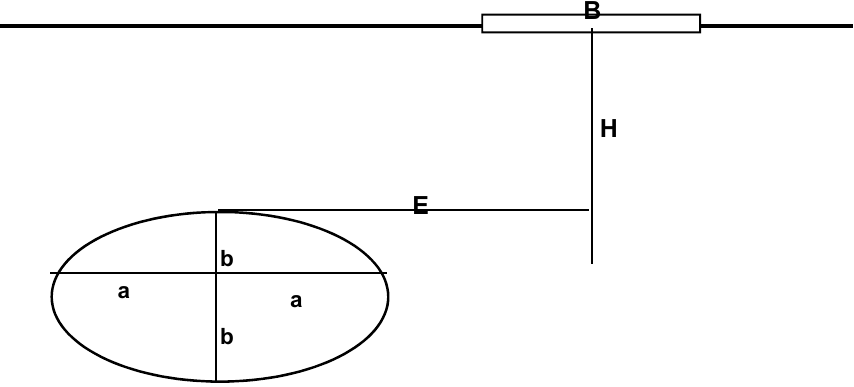
Figure 1. Geometry: a: horizontal semi-axis, b: vertical semi-axis, E: load eccentricity, H: cavity depth or cover thickness, B: foundation width.